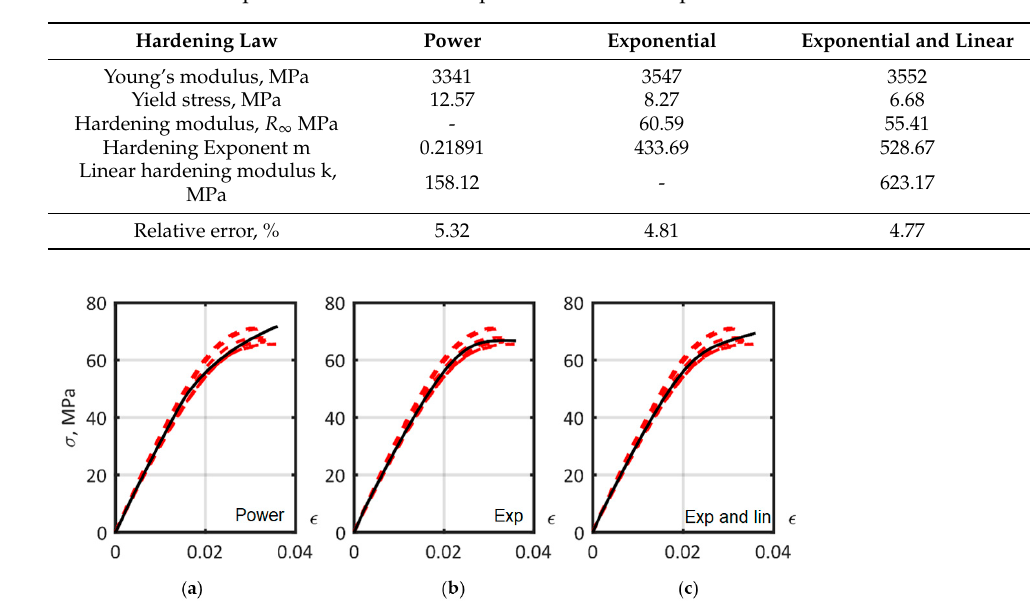
Figure 13. Experimental stress–strain curves for ISO 527-2 samples of PA6 composites with different fiber mass fractions, cut at 0 ◦ , 45 ◦ and 90 ◦ angles to flow direction: ( a ) 10%; ( b ) 15%; ( c ) 20%; ( d ) 30%. Table 2. Calibrated pure PA6 tension curve parameters of elastoplastic matrix material models.